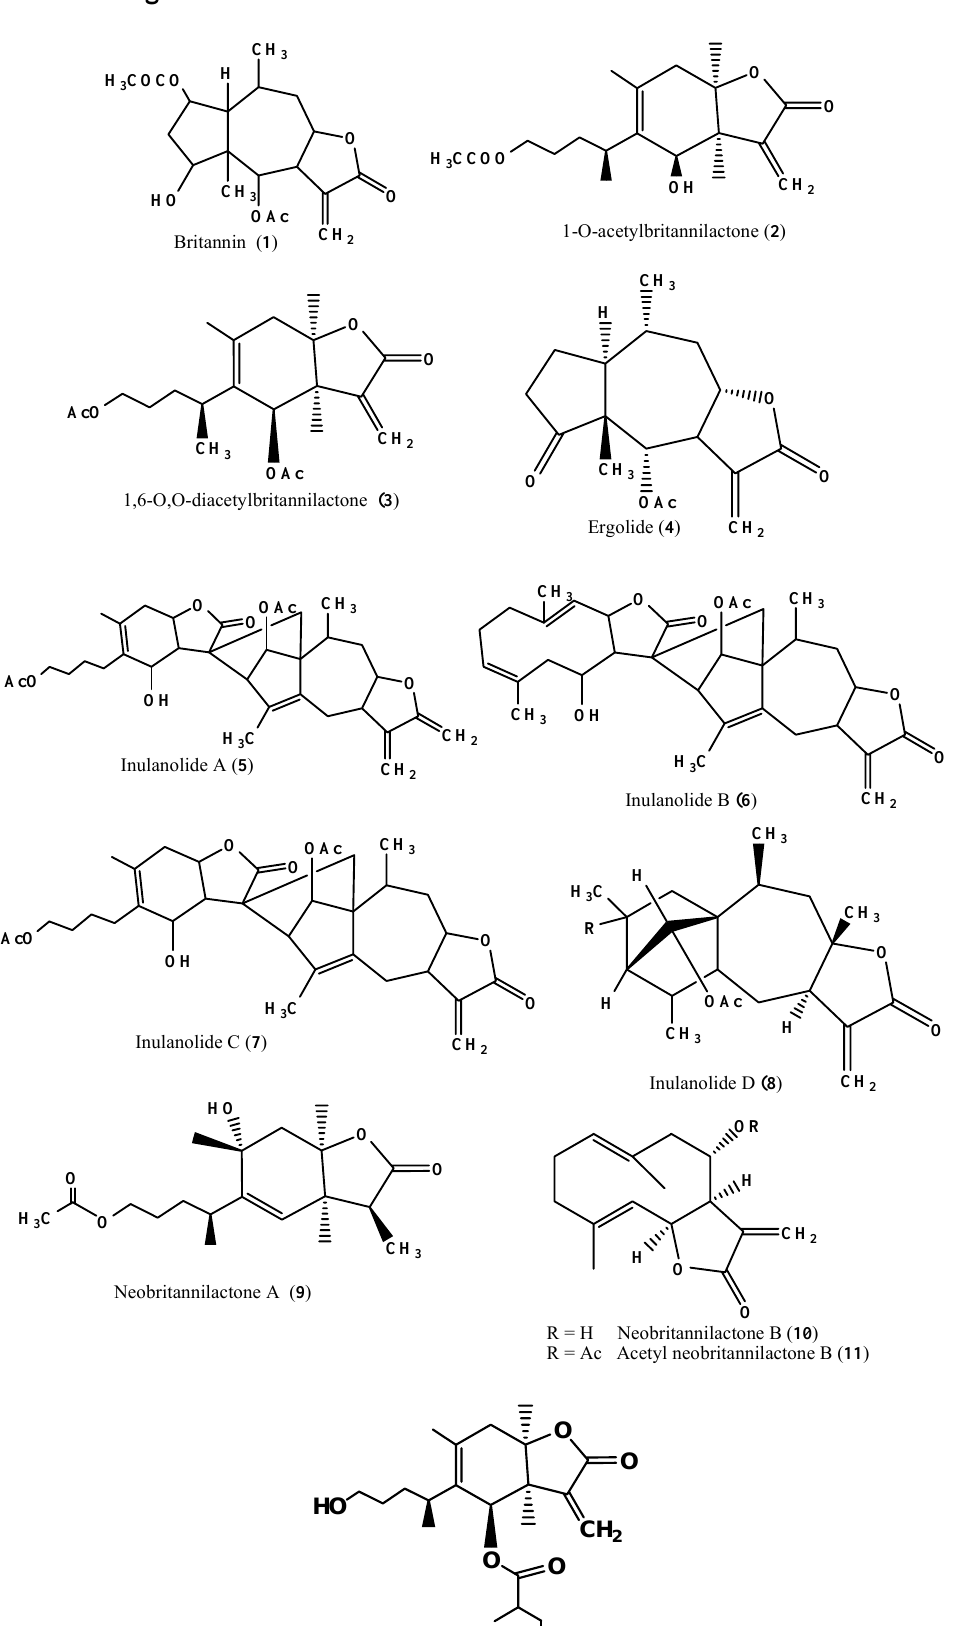
Figure 2. Bioactive metabolites isolated from I.